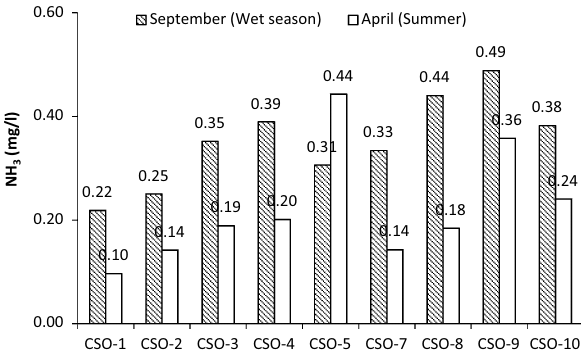
Fig. 8 Variation of nitrate (exprssed as NO -N, mg/l) at 3 sampling times at the sampling locations close to CSO-1 and CSO- 5. Overflows took place through CSO-1 during wet season (June to October), while there were no overflows through